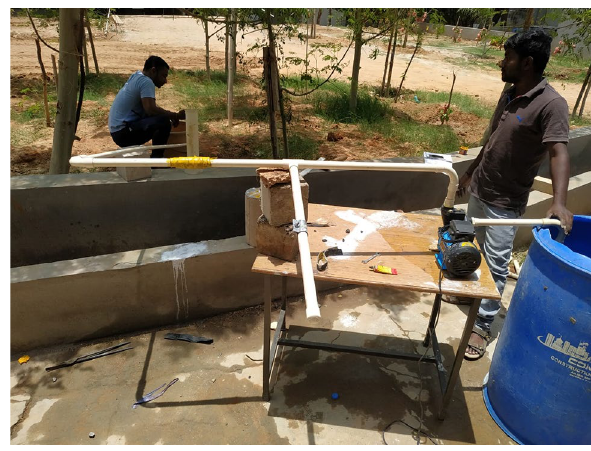
Fig. 4 Conduction of experiment by modeling as per above